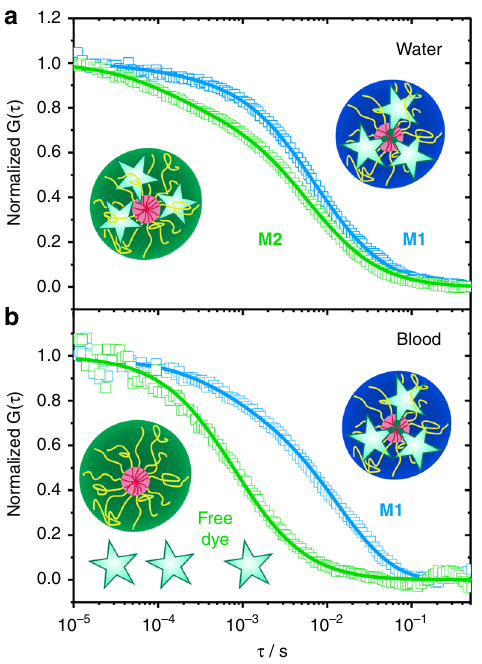
Fig. 4 NIR-FCS studies of the loading stability of core-crosslinked micelle nanocarriers in blood. Normalized autocorrelation curves (symbols) and the corresponding fi ts (lines) are shown for core-crosslinked micelles that were either covalently ( M1 , blue color) or noncovalently ( M2 , green color) loaded with IRDye ® 800CW. a Measurements in water. The dye is mainly loaded to the core-crosslinked micelles and only a small fraction of free dye was detected for both systems. b Measurements in the blood fl ow (velocity of 50 µ L h − 1 ) upon incubation with blood for 30 h (at 4 °C). The dye is fully released from M2 , but still loaded to